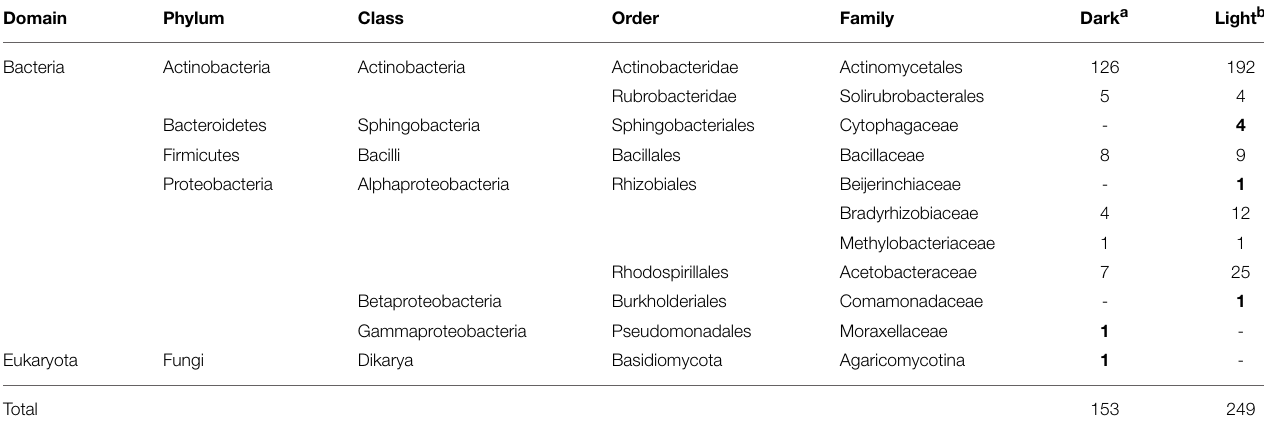
TABLE 1 | Taxonomic distribution of isolates from the early successional stage desert Biological Soil Crust from Moab,